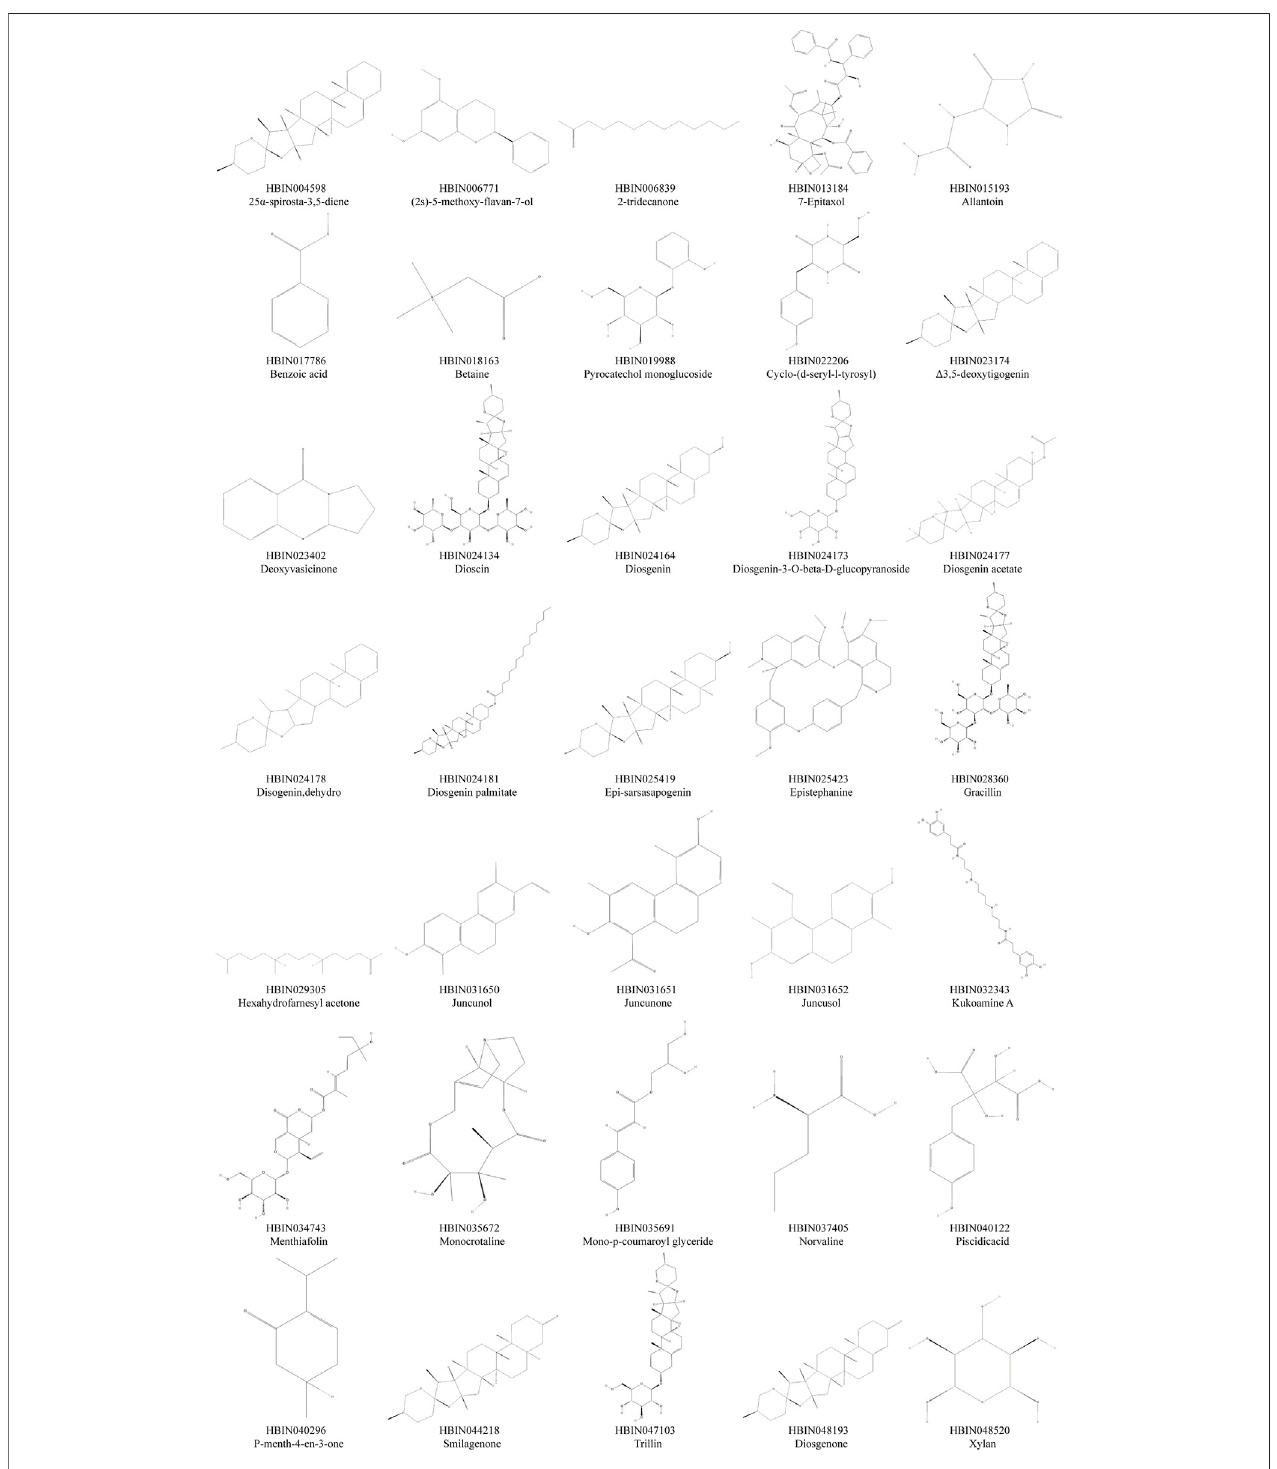
FIGURE 2 | The chemical structure of active componds in DNR.